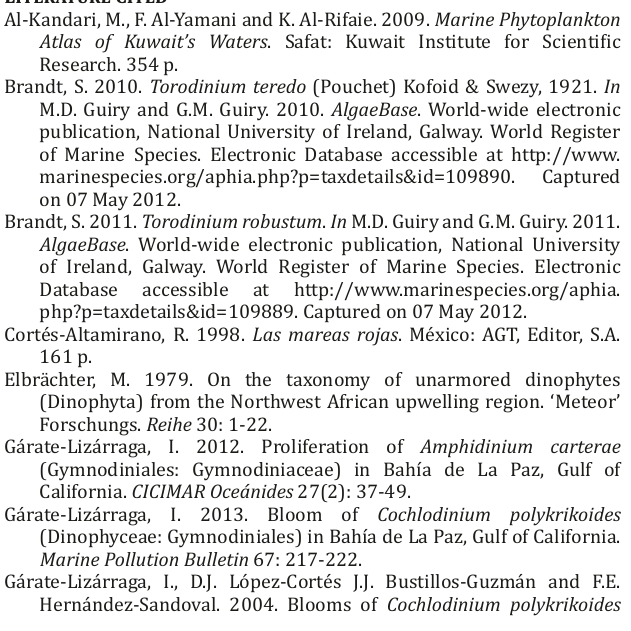
Table 1 . Geographic coordinates for each station, sampling date, number of specimens of